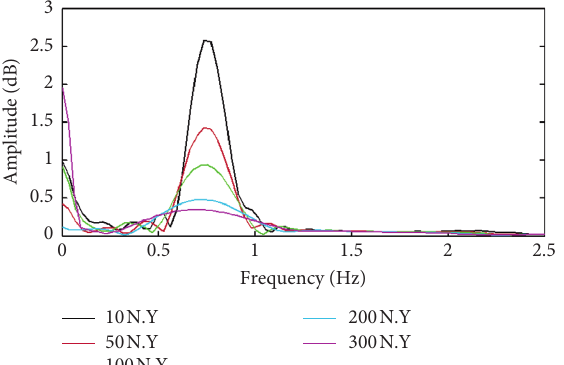
Figure 16: The frequency domain response analysis of the platform centroid in Y direction when β � ( π /6 ) and ϕ � ( π /2 ) under different loads between the upper and lower disc